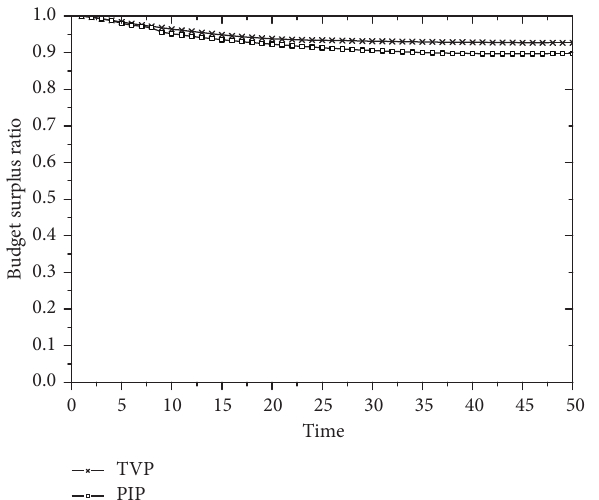
Figure 5: Task type where utility is directly proportional to subtask